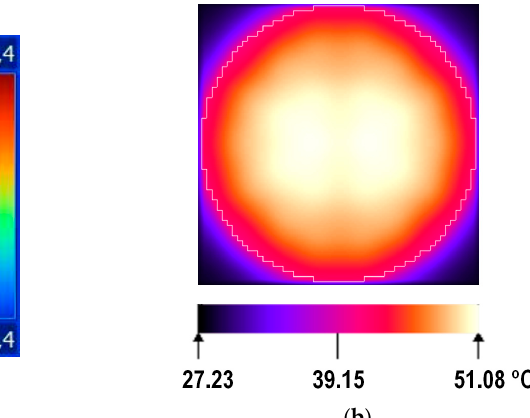
Figure 28. The measured transient of the average temperature of the CoB device and two thermal images grabbed during the heating up process of a physical sample of the investigated CoB device.